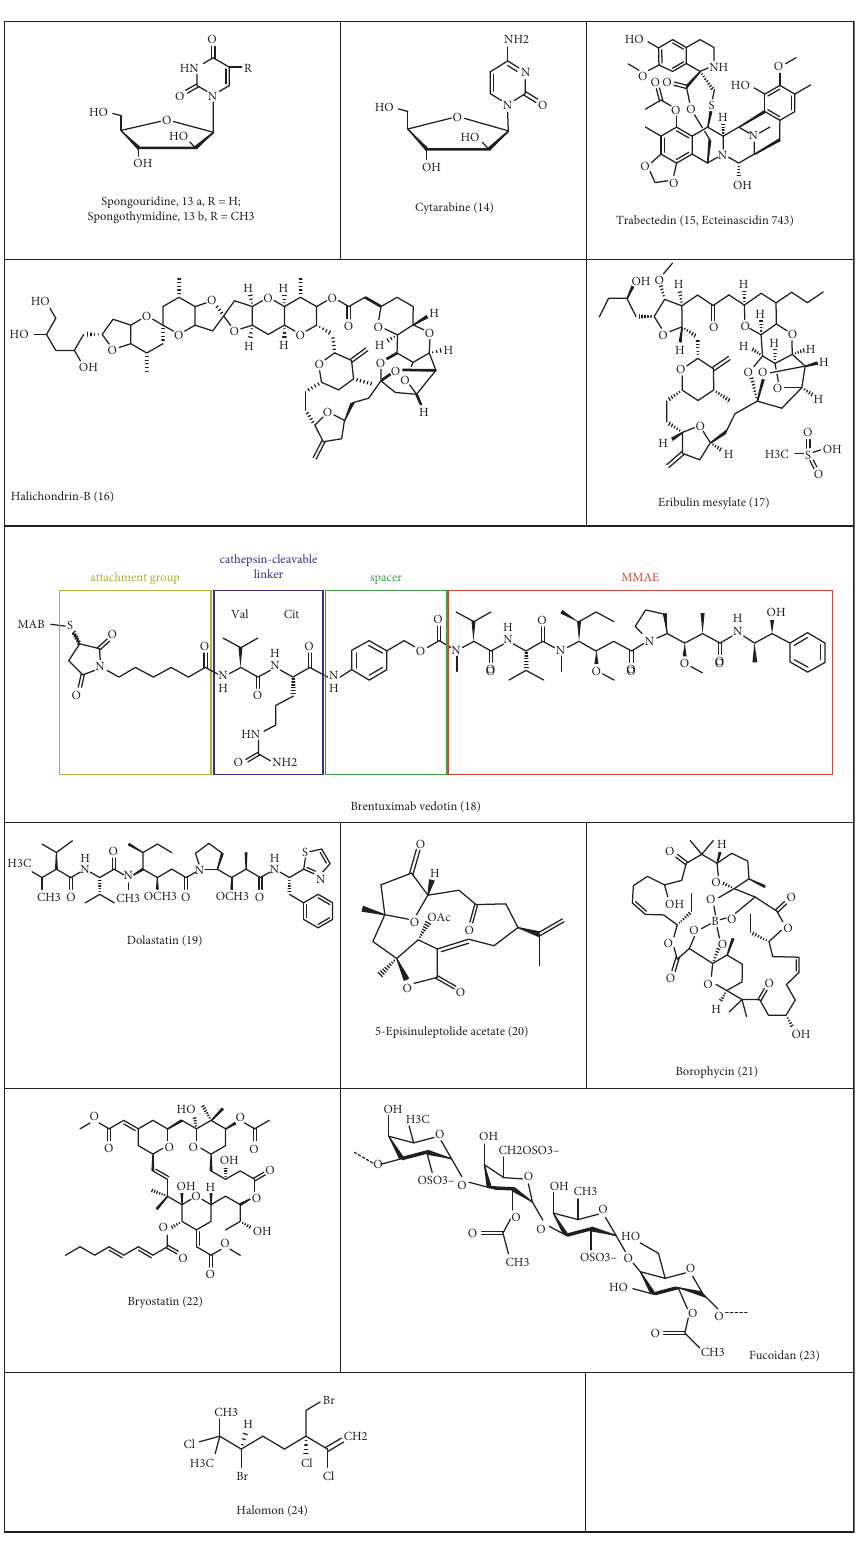
Figure 2: Chemotherapeutic agents obtained from marine